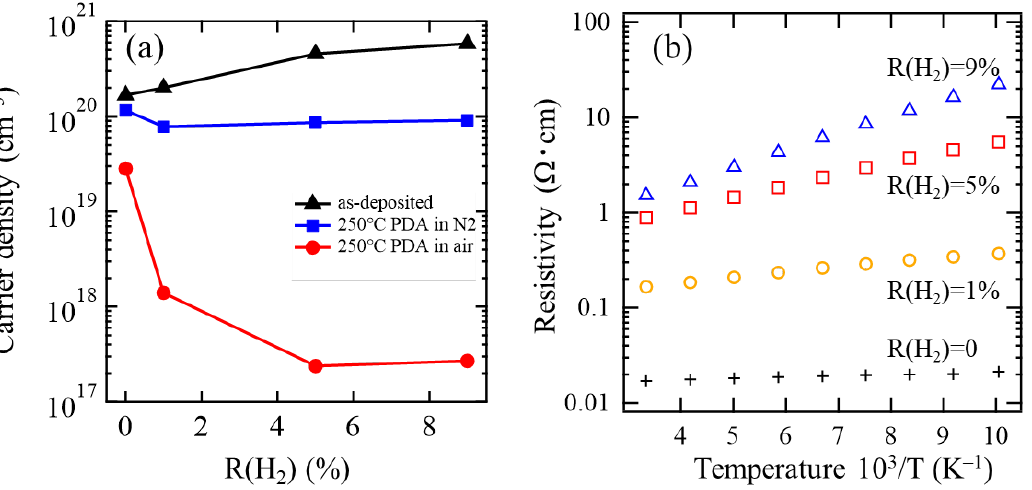
Figure 5. ( a ) Carrier density of InO x [R(H 2 ) = 0] and InO x :H [R(H 2 ) = 1, 5, 9%] films before (as-depos-